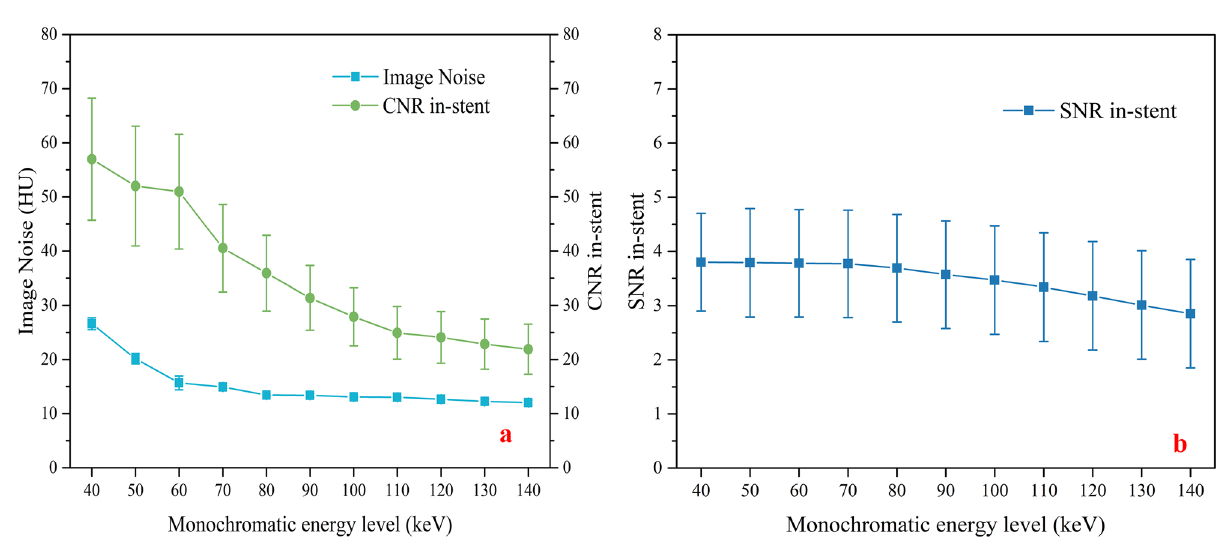
Figure 1. Comparison of image noise and CNR of in-stent ( a ) and comparison of SNR of in-stent ( b ) at monochromatic energy levels between 40 and 140 keV in 10-keV